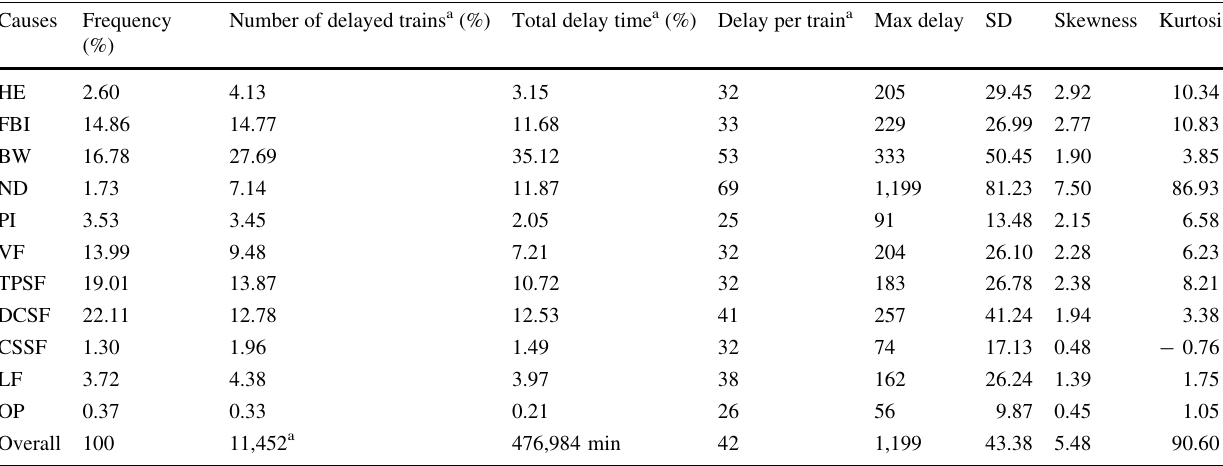
Table 3 Overall statistical analysis of delayed train data Causes